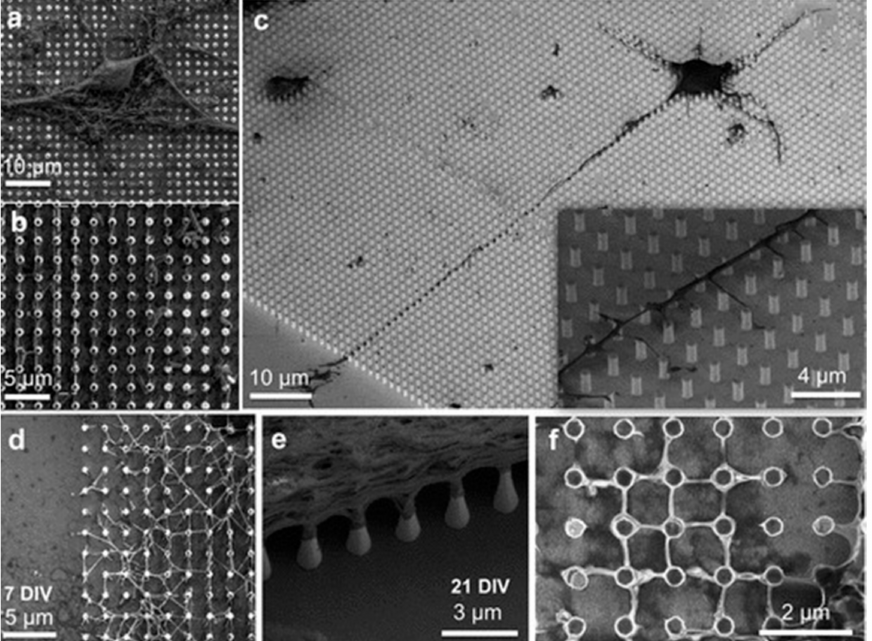
Figure 3. SEM images of the growth of neurons and neurites on nanowire arrays. ( a ) A cell body from hippocampal culture on the nanowire array, top view, after 20 DIV. ( b ) Another area on the same substrate as in panel ( a ), where neurites can be seen to grow along the nanowires, top view. ( c ) A neuron from cortical culture after 2 DIV. The inset depicts a closer view around the axon. ( d , e ) Cellular network on the edge of the nanowire array after 7 and 21 DIV, respectively. ( f ) Neurite growth on an area of nanowires after 5 DIV showing anchoring and secondary branching of neurites at the nanowires. Adapted with permission from Ref. [17]. Copyright (2017) American Chemical